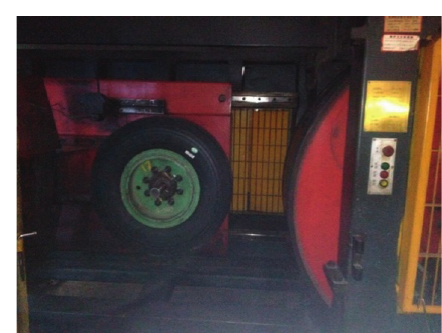
Figure 2: Real fatigue test stand with a tire.